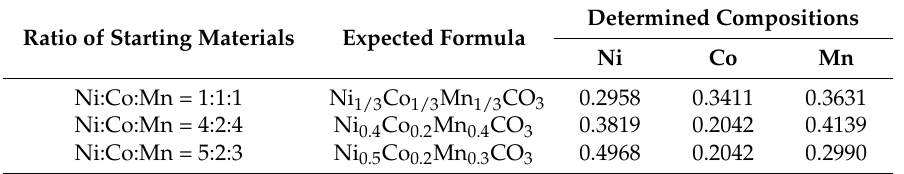
Ratio of Starting Materials Expected